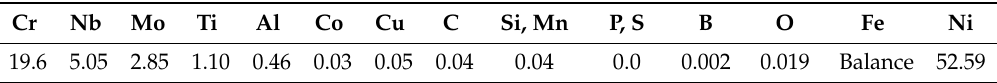
Table 1. Chemical composition of IN718 powder used in selective laser melting (SLM) (mass %). Cr Nb Mo Ti Al Co Cu C Si, Mn P, S